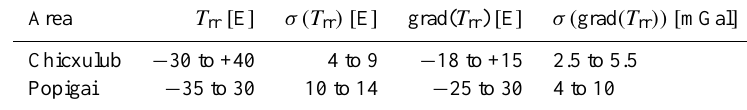
Table 2. Range of T rr , grad( T rr ) and its estimated errors according to Eq. (6) for the Chicxulub and Popigai areas. Area T rr [ E ] σ (T rr ) [ E ] grad( T rr ) [ E ] σ ( grad (T rr )) [ mGal ]